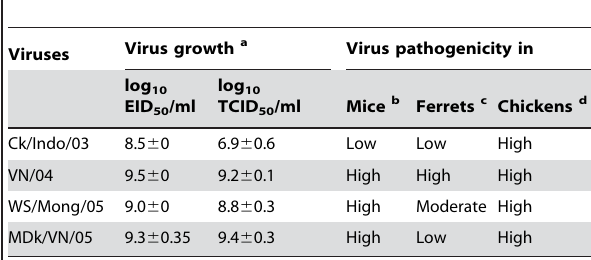
Table 1. Growth and pathogenicity of H5N1 viruses